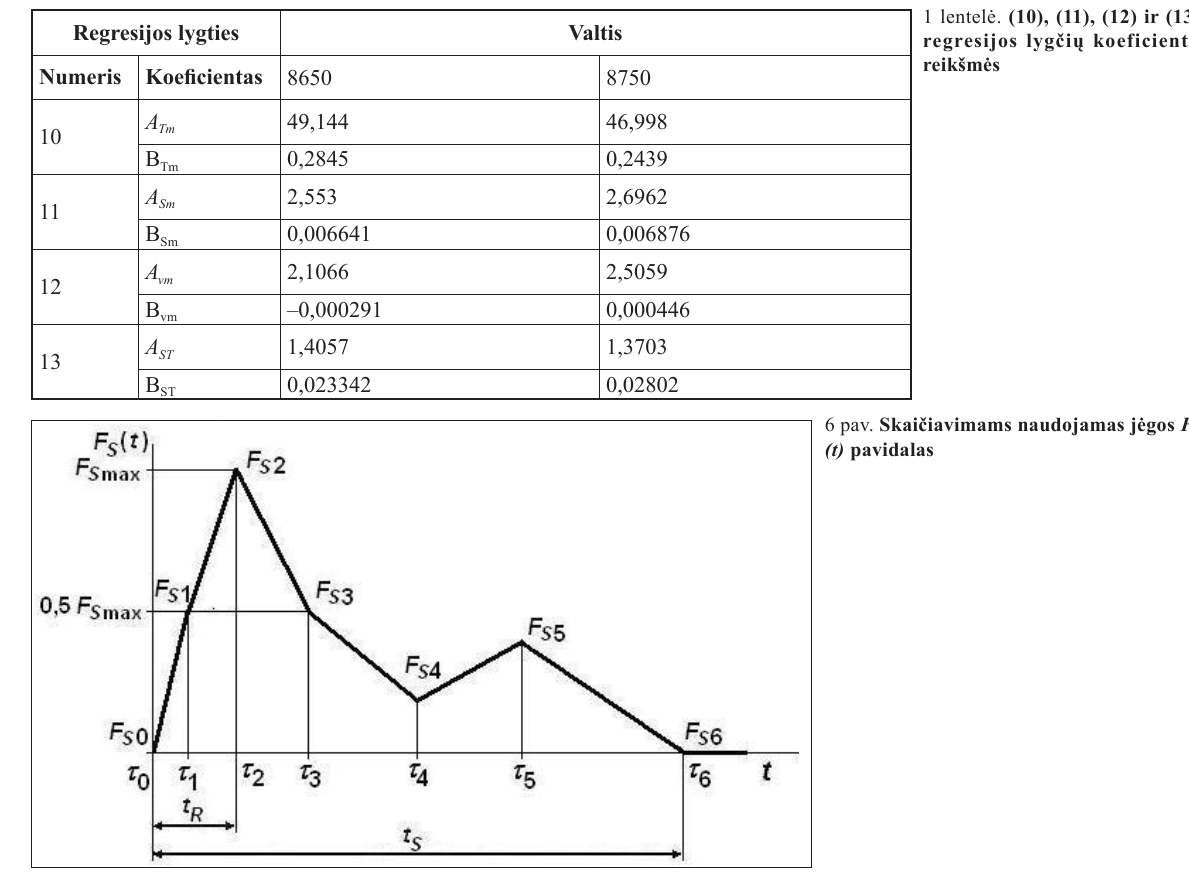
e fi cientus v ( Семенов - Тян - Шанский и др ., 1969). Val č i ų rodikliai apskai č iuojami valties komplekso mas ė s m ribose nuo 332 iki 492 kg. Į mas ę m į eina keturi ų irkluotoj ų vienodos mas ė s m iki 105 kg. Val č i ų rodikli ų priklausomyb ė gra fi škai pavaizduota 2, 3, 4 ir 5 pav.